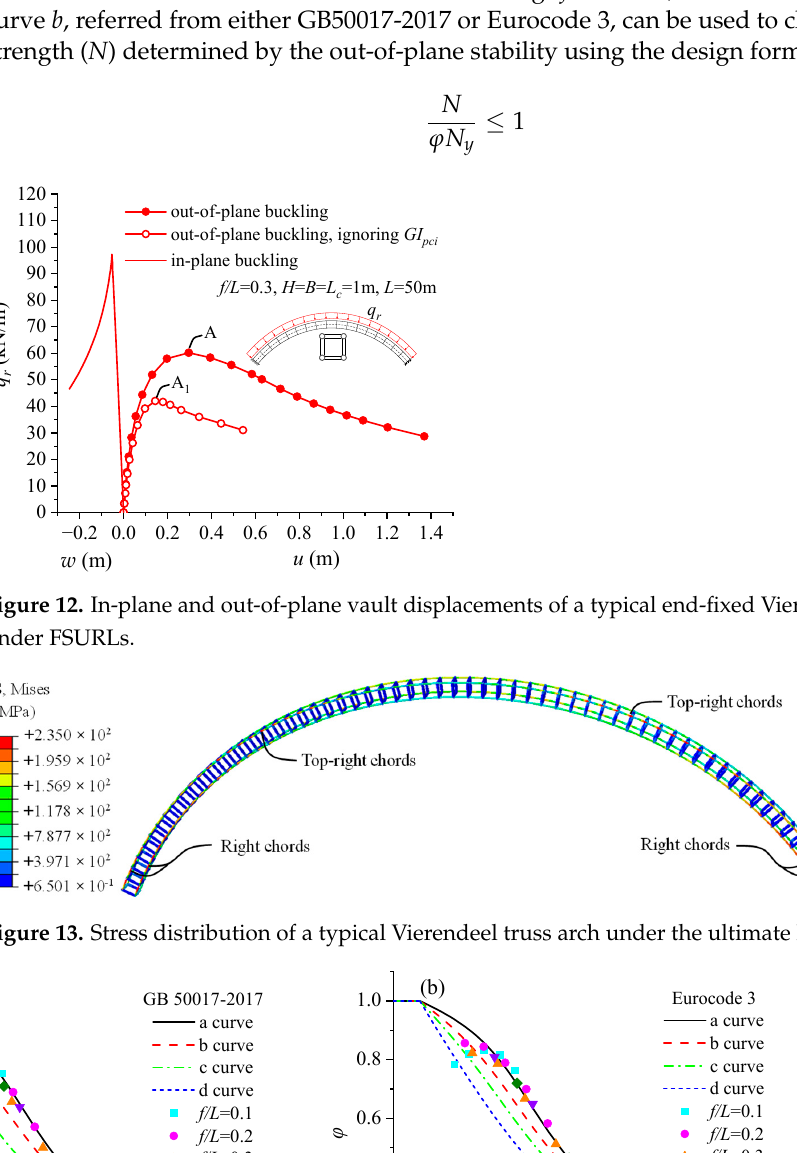
Under the full-span uniform vertical load (FSUVL), the end- fi xed circular truss arches tend to be under the combined actions consisting of compression, bending, and shear. For